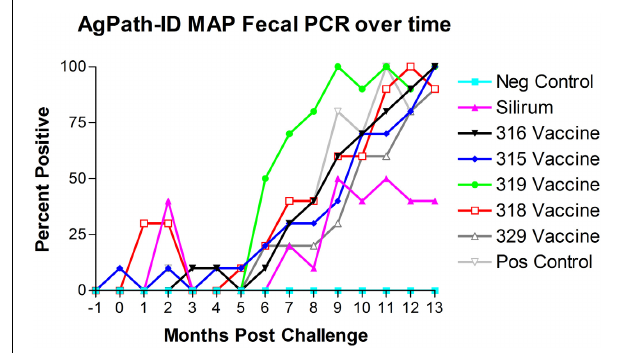
FIGURE 4 | Monthly fecal AgPath-ID™ PCR results throughout the study. No positive samples were detected in the non-challenged control group. ( − 1 is baseline bleeding, 0 is challenge date and 1–13 represents months